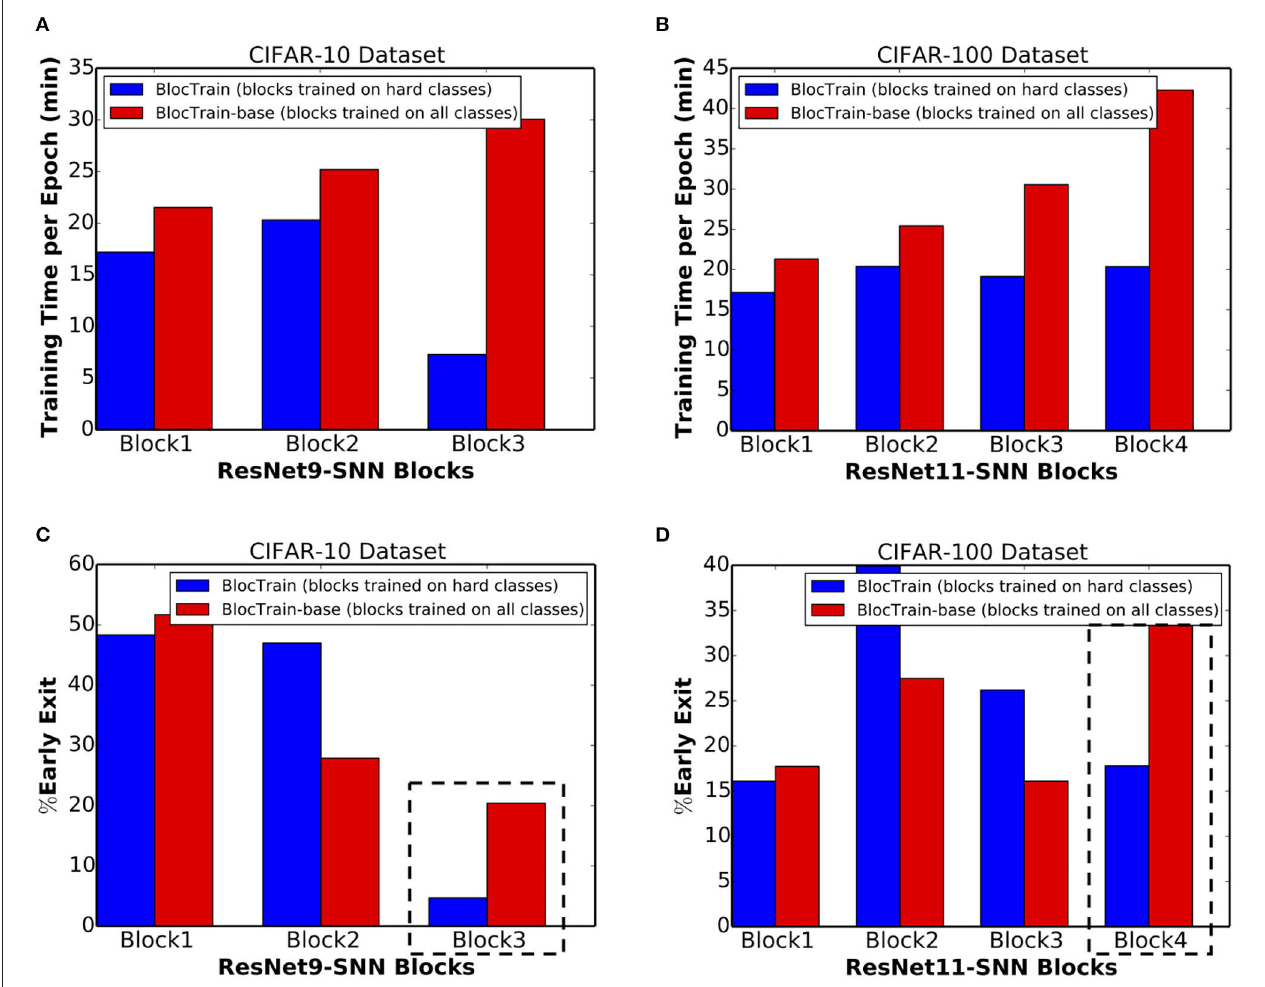
FIGURE 10 | (A) Training time per epoch incurred by successive blocks of ResNet-9 spiking neural network (SNN), trained on CIFAR-10 using BlocTrain, wherein deeper blocks are trained on hard classes, and BlocTrain-base, wherein deeper blocks are trained on all classes. (B) Training time per epoch incurred by successive blocks of ResNet-11 SNN, trained using BlocTrain and BlocTrain-base methods, on the CIFAR-100 dataset. (C) Percentage of exiting inputs per block for ResNet-9 SNN, trained using BlocTrain and BlocTrain-base methods, on the CIFAR-10 dataset. (D) Percentage of exiting inputs per block for ResNet-11 SNN, trained using BlocTrain and BlocTrain-base methods, on the CIFAR-100